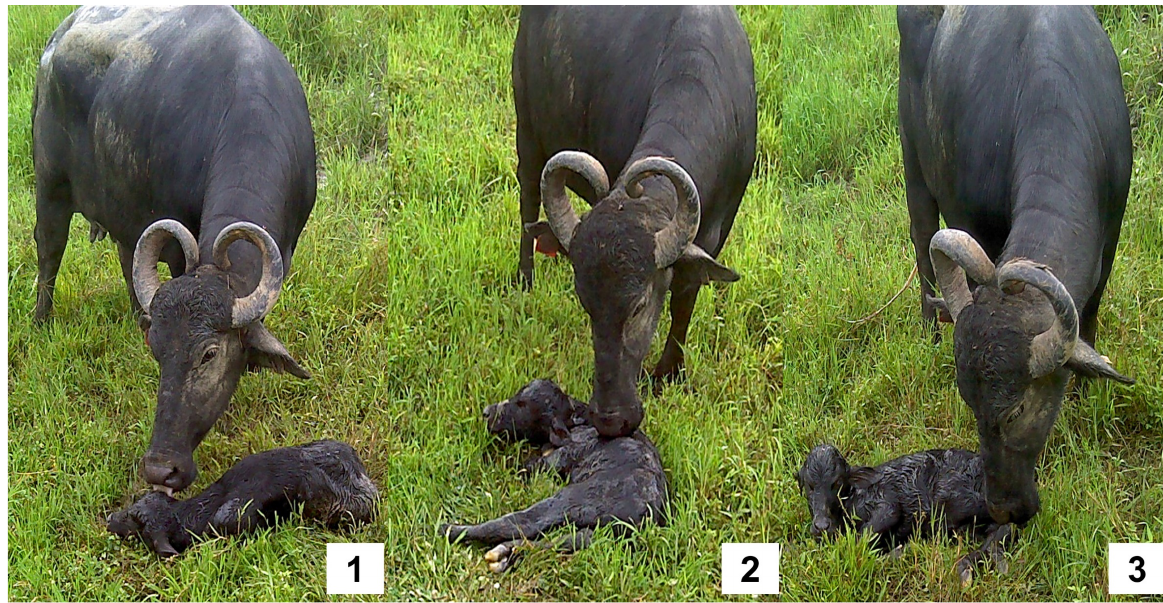
Figure 3. Sequential behavior of the licking of newborn water buffalo. (1) The beginning of grooming in the cranial region (nose, ears, mouth), moving towards the back (2) and ending in the anogenital region and limbs (3). This behavior can continue for up to 50 min. Although this is the regular pattern, the authors have detected that licking can start with the limbs and move in a cranial direction.